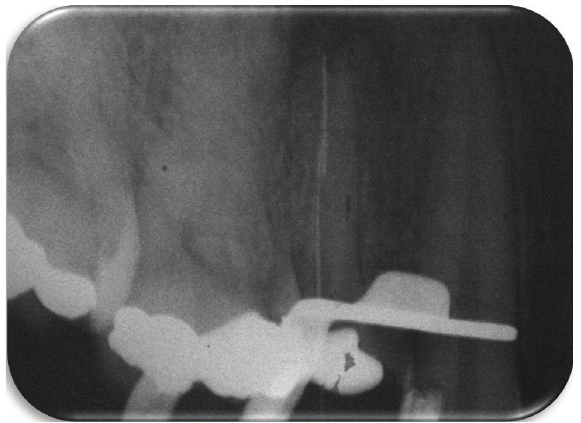
Figure 2: Periapical radiograph of the moment when trying to bypass the fractured instrument using manual